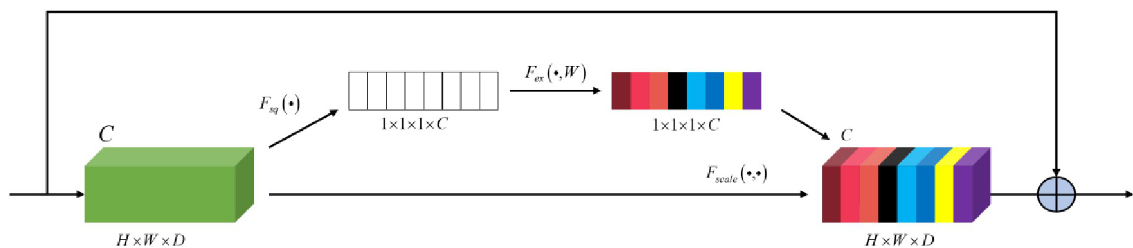
Fig 7. Structure of the feature recalibration